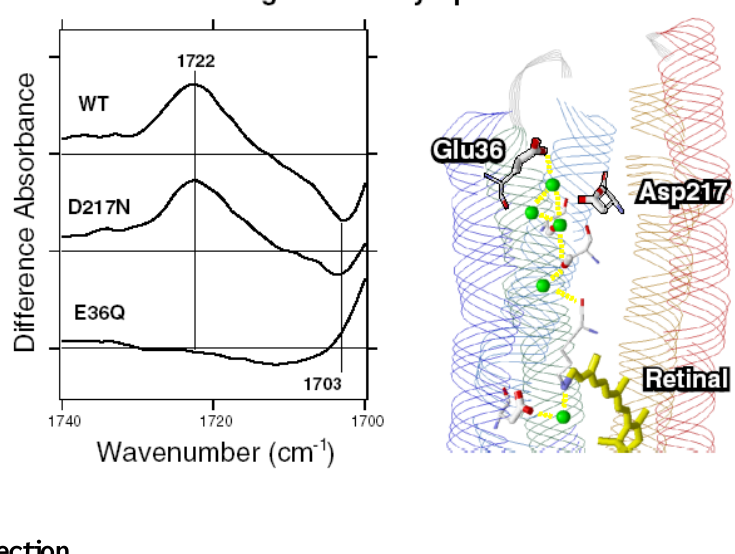
Figure 39. The structural changes of ASR in L-intermediate. (Left) The ASR infrared spectra in protonated carboxylic acid region. (Right) The structure of ASR in cytoplasmic surface. Yellow broken lines indicates hydrogen bond, green spheres are water molecules. This figure is reprinted with permission from TOC of Kawanabe et al